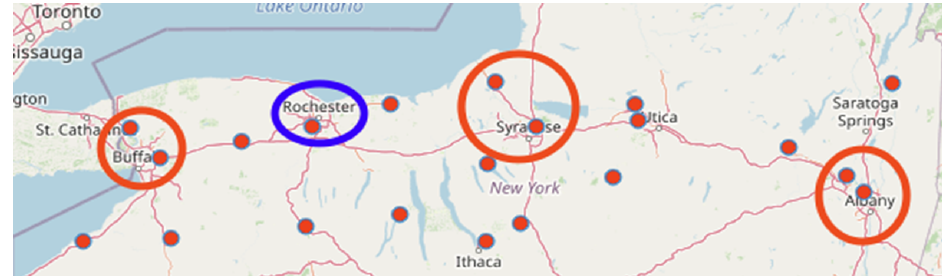
Figure 1. Weather stations in Upstate New York. The blue circle indicates that ROC dataset is from Rochester station and the red circles are Buffalo’s two stations, Syracuse’s two stations, and Albany’s two stations. Both the blue and red circles contribute to the mixed